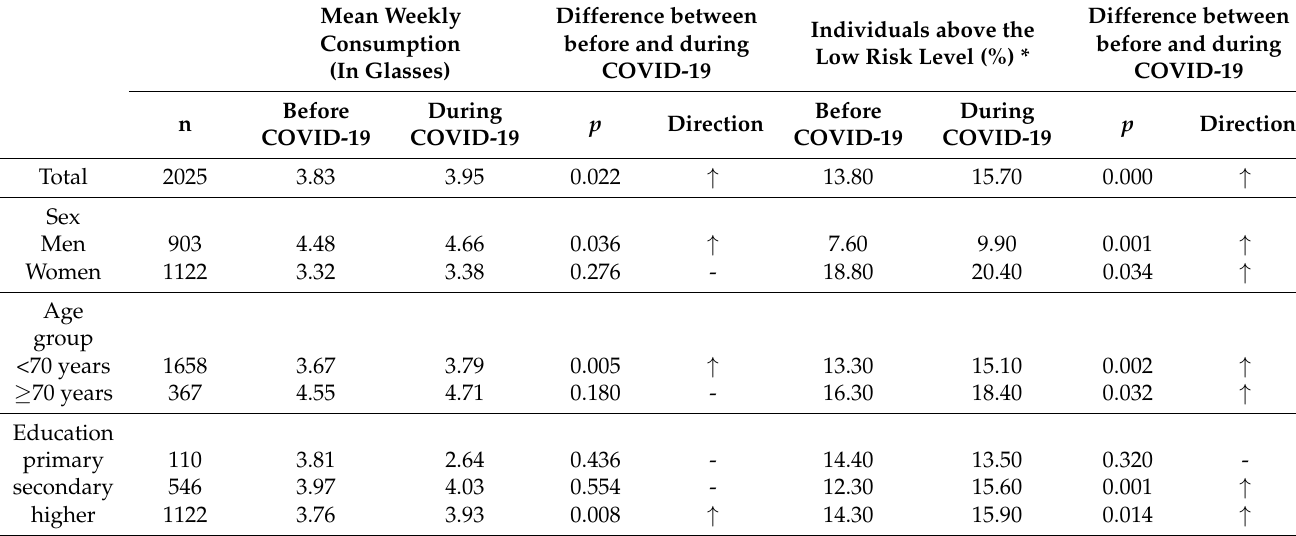
Difference between before and during